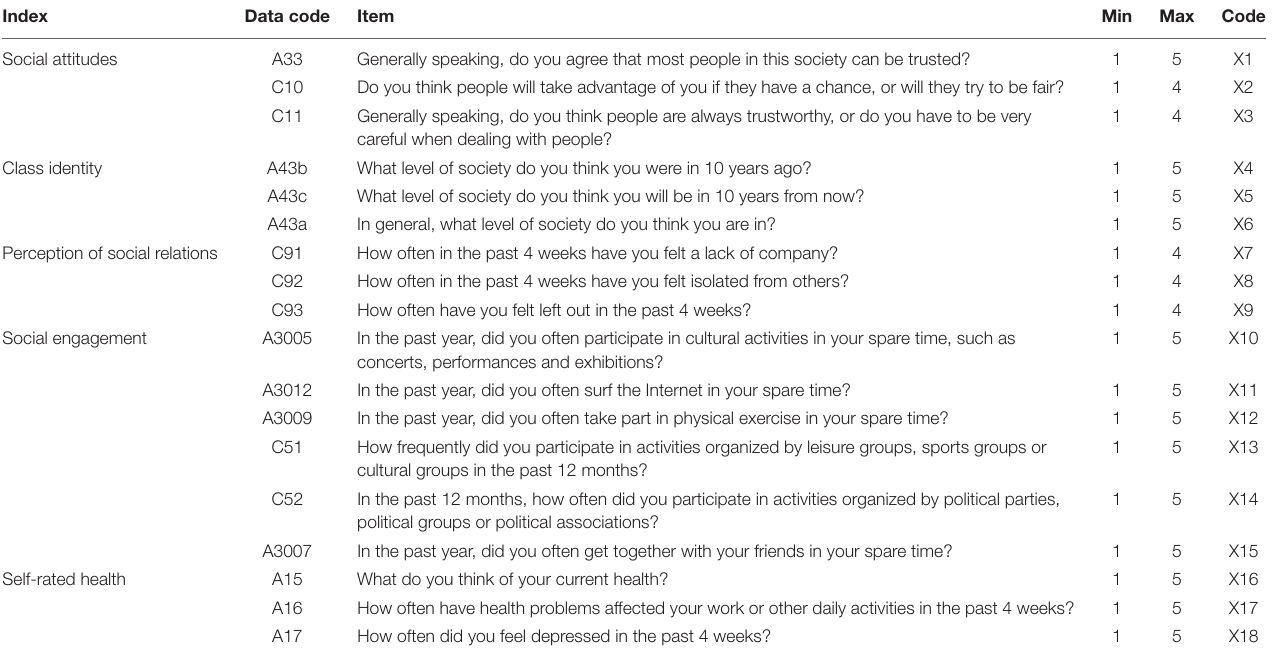
TABLE 1 | Distribution and coding of variable